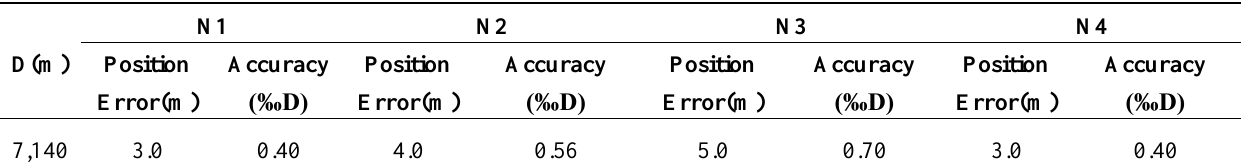
Table 4. Validation of Calibrated parameter